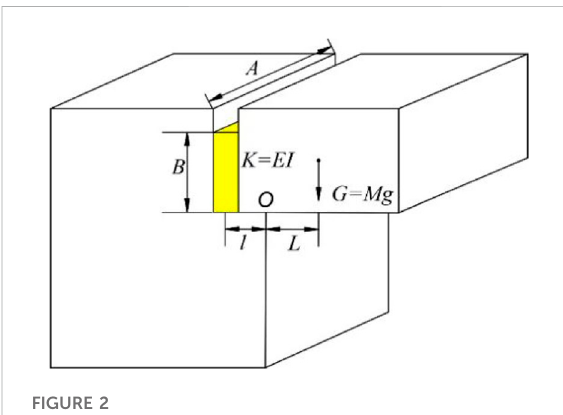
FIGURE 3 Vibration model of toppling dangerous